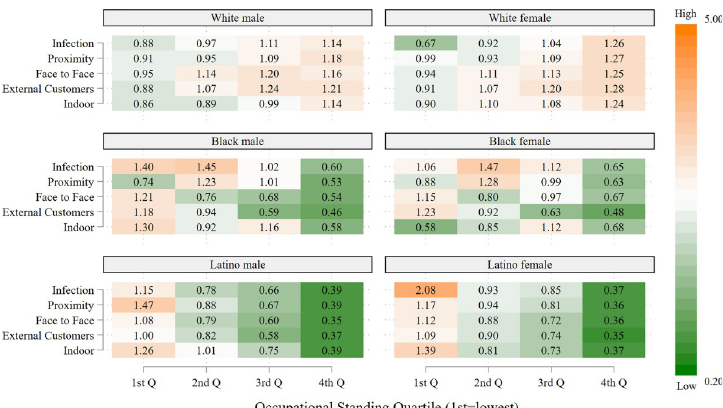
Fig 2. Representation of frontline workers in high-risk occupations relative to representation as frontline workers by occupational standing: White, Black and Latino workers, by sex. Data are from the 2018 American Community Survey (ACS). Occupations are considered to be high-risk if the average value for the risk factor in the O � NET data falls in the highest quartile of the occupations in the analysis. Occupational standing (OS) is defined as the percentage of ACS respondents reporting this occupation who completed at least one year of college education. The 1 st OS quartile is the lowest and the 4 th OS quartile the